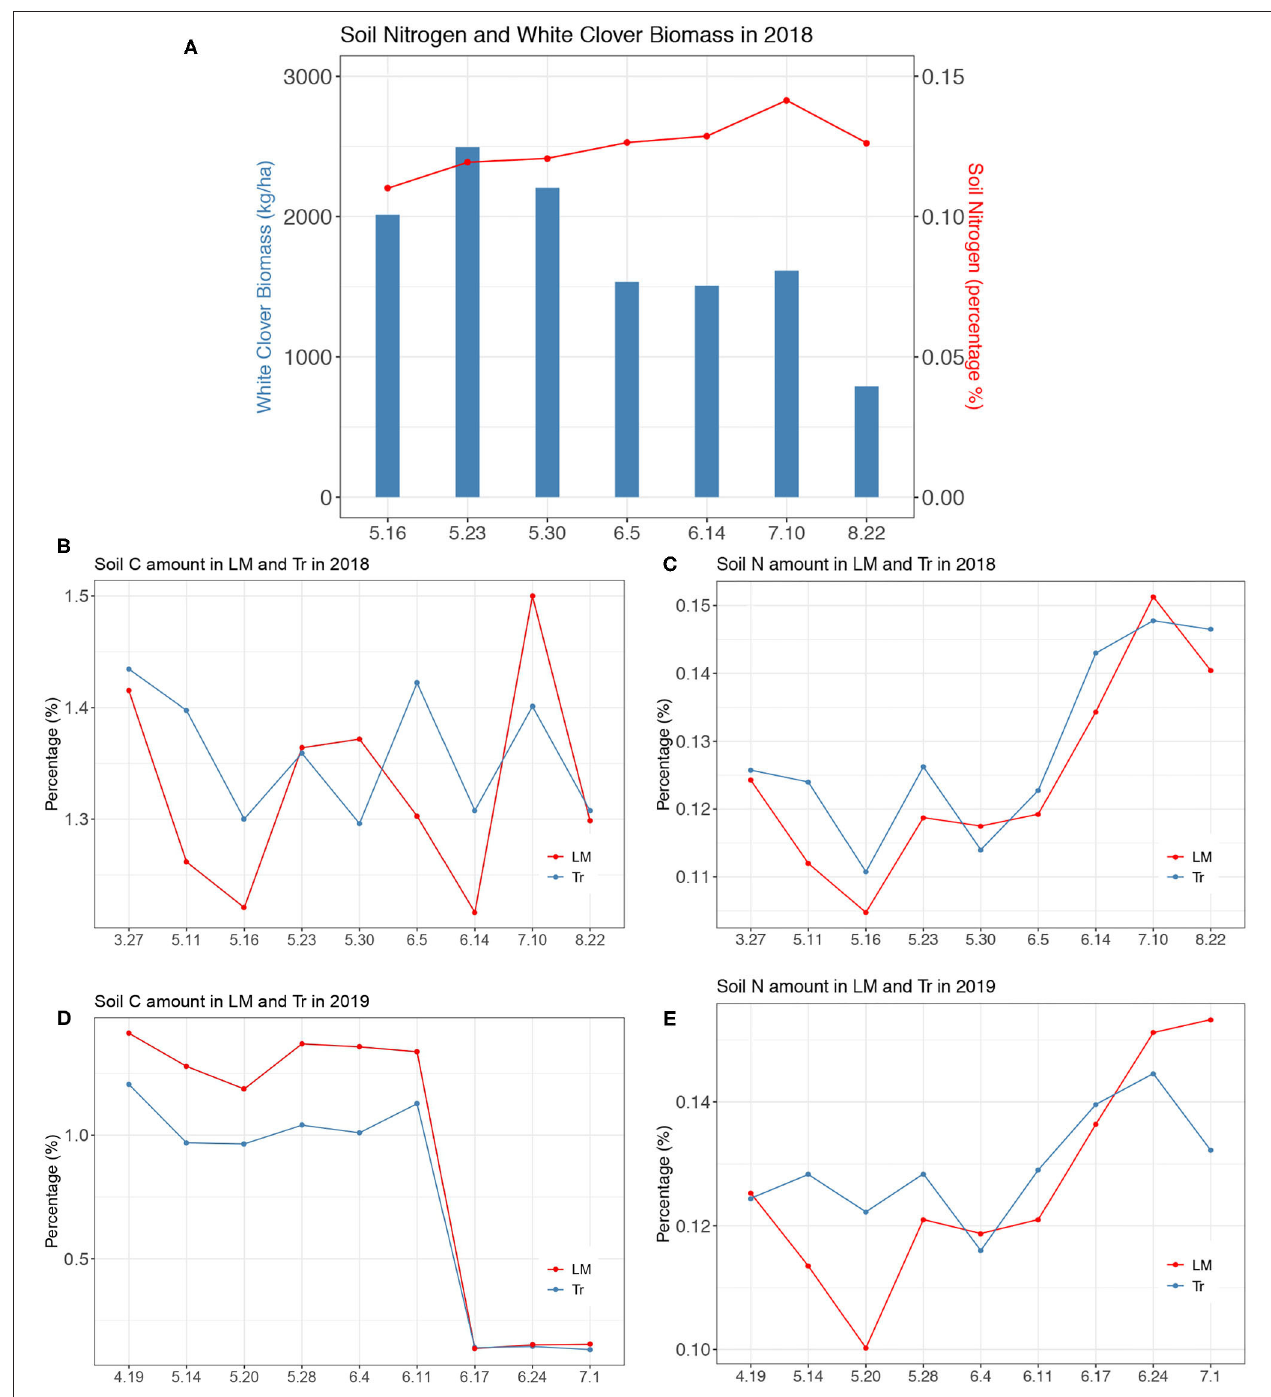
FIGURE 4 | (A) The relationship between soil nitrogen content (percentage %) and white clover biomass (kg ha − 1 ) in 2018, (B) Soil C amount measured in rows of maize under LM and Tr in 2018, (C) Soil N amount measured in rows of maize under LM and Tr in 2018, (D) Soil C amount measured in rows of maize under LM and Tr in 2019, (E) Soil N amount measured in rows of maize under LM and Tr in